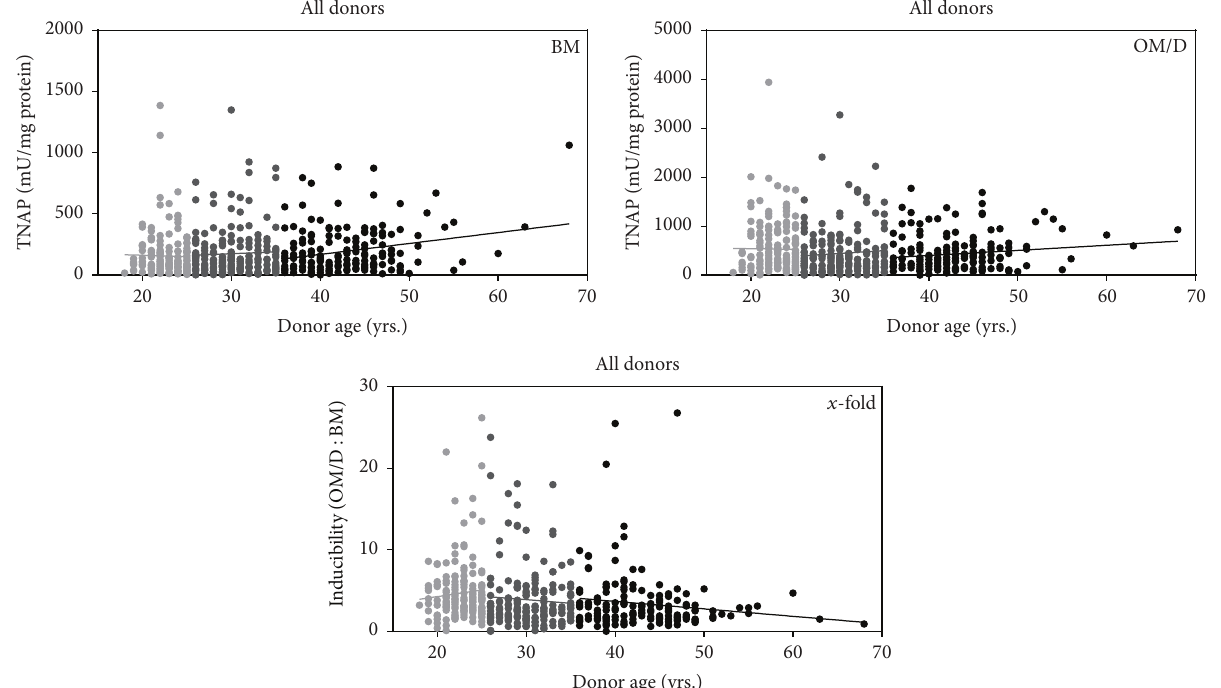
Figure 3: Correlation of donor age with TNAP activity and inducibility. hBMSC in passage 1 were plated in BM (basic medium) onto TCPS (= P2). From day 4 after plating, the cells were cultured either in BM or in OM/D (osteogenic differentiation medium). At day 15 after plating, the cells were analyzed for TNAP activity as described above. Data for endogenous TNAP activity, TNAP activity in OM/D, and TNAP inducibility for each donor age group were plotted each in one graph. The lines indicate linear curve fit. Regression characteristics ( 𝑝 -value, 𝑅 -square) and the number of analyzed donors are given in Table